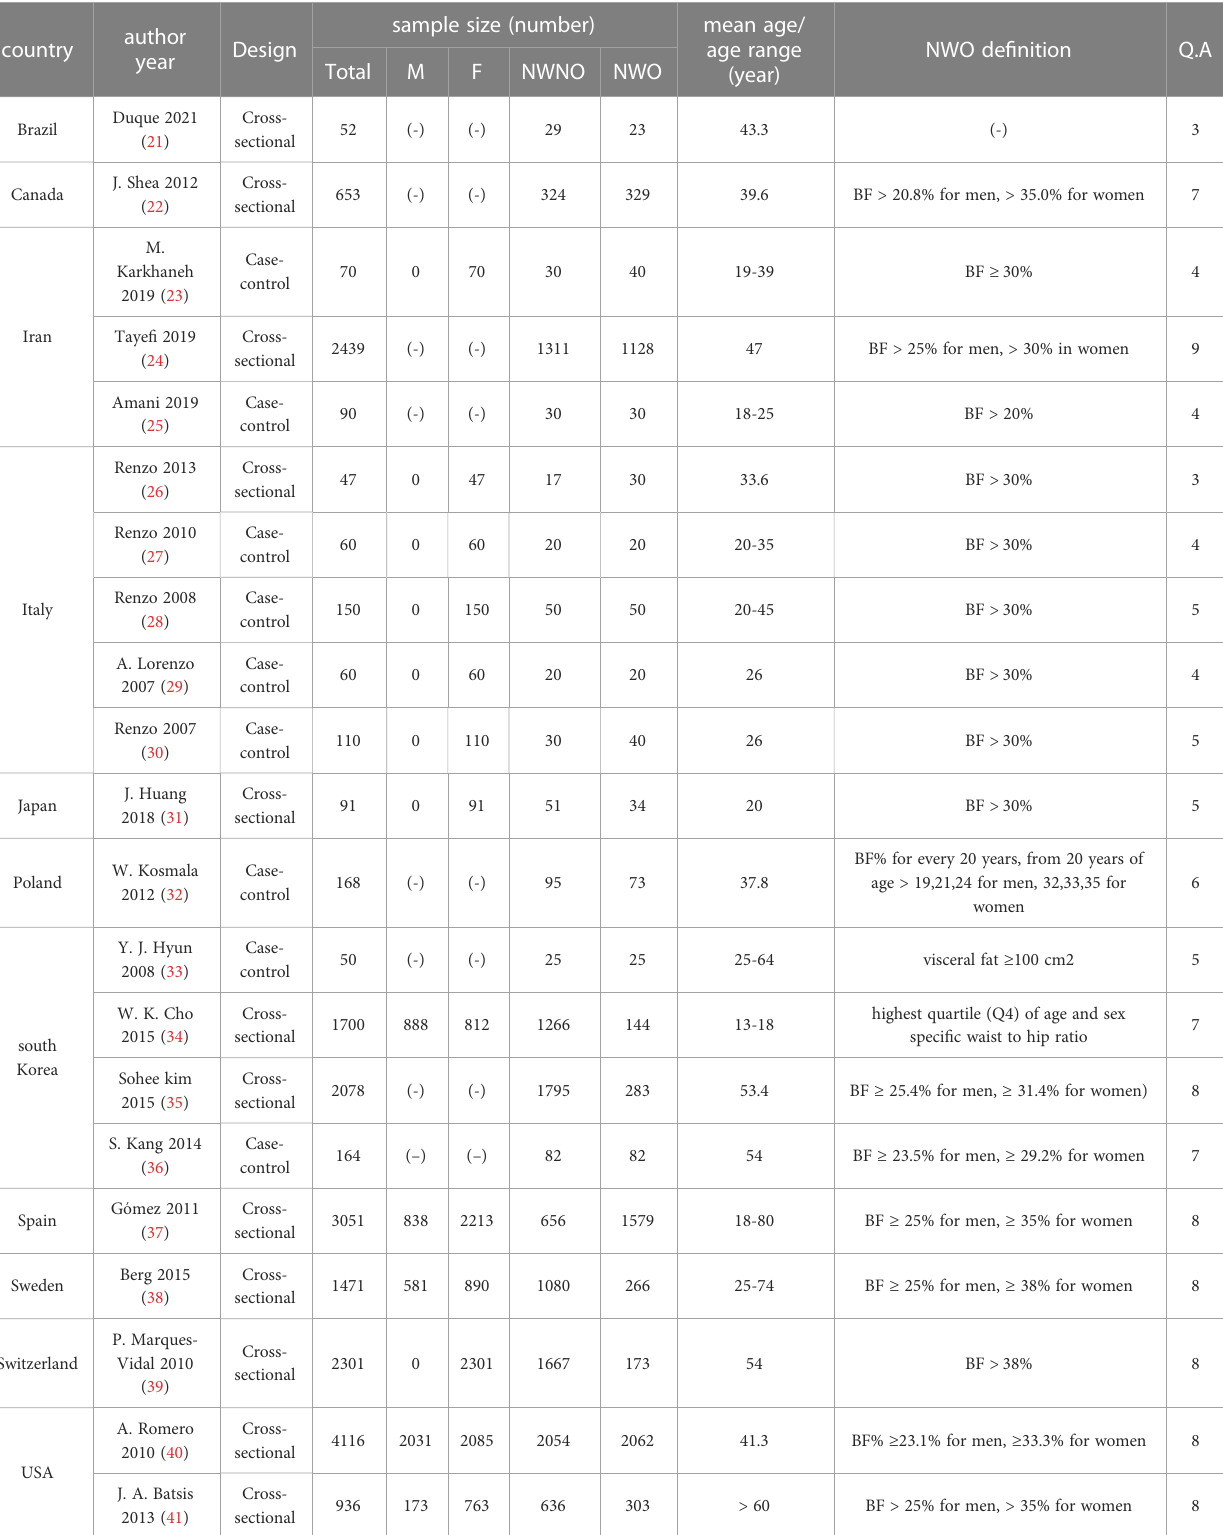
TABLE 1 General Characteristics of included studies for association of NWO and in fl ammatory factors.